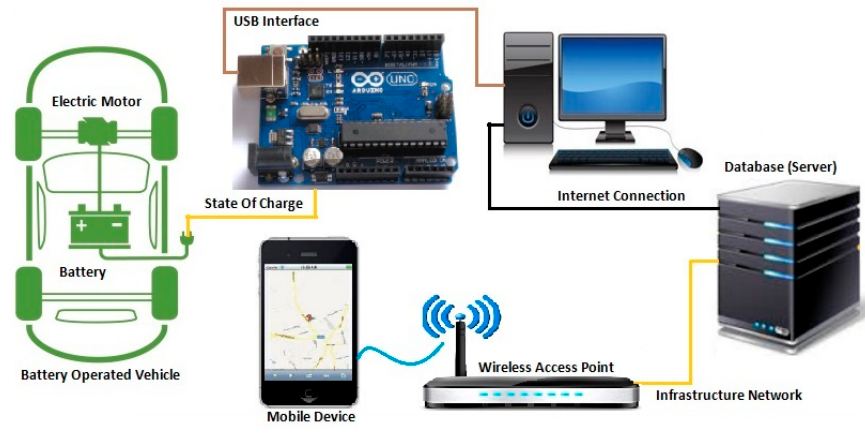
Figure 6. Schematic of the system.